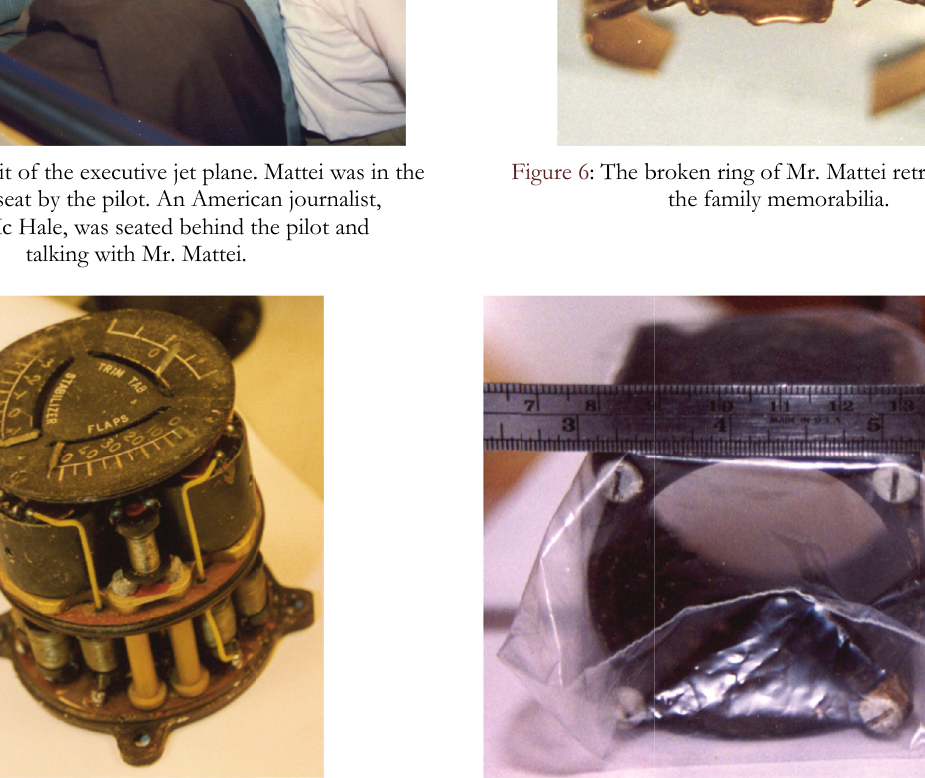
Figure 7: A trip n explosion o amined by op d heat wave.